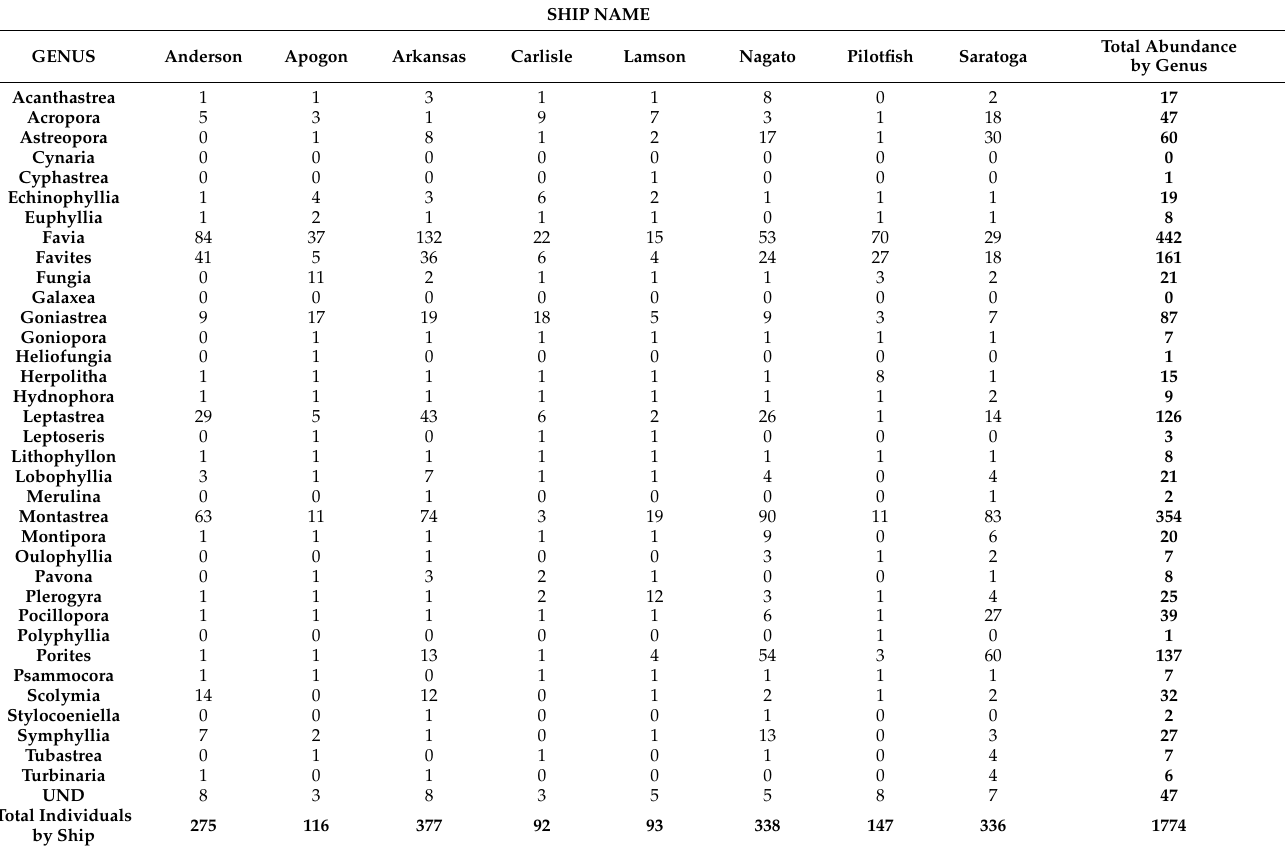
Table A1. Listing of coral genera found on eight ships in the lagoon of Bikini